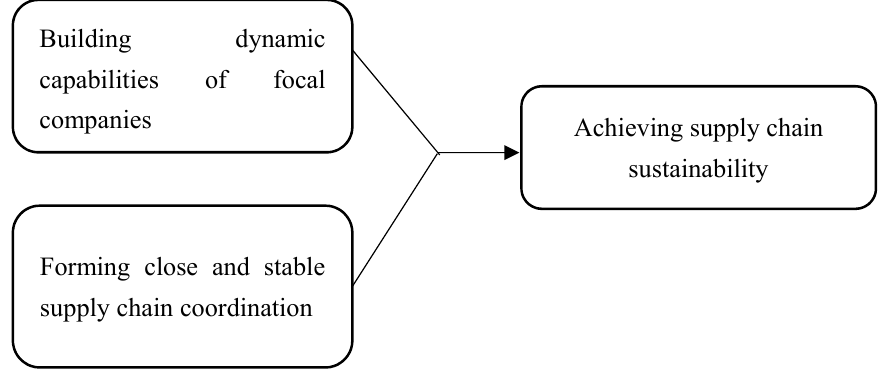
Figure 1. Pathway to achieve supply chain sustainability.